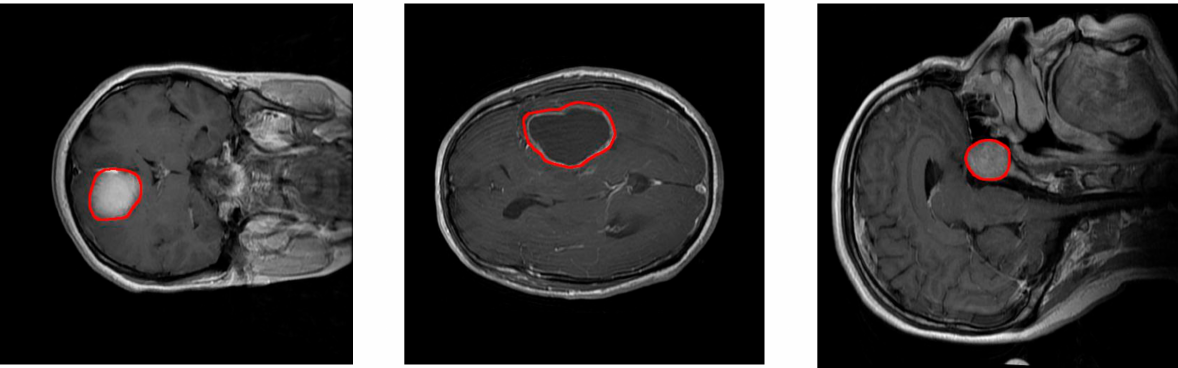
Figure 1. Examples of MRI images of the T1-CE MRI image dataset. Left: coronal view of a meningioma tumor. Center: Axial view of a glioma tumor. Right: sagittal view of a pituitary tumor. Tumor borders have been highlighted in